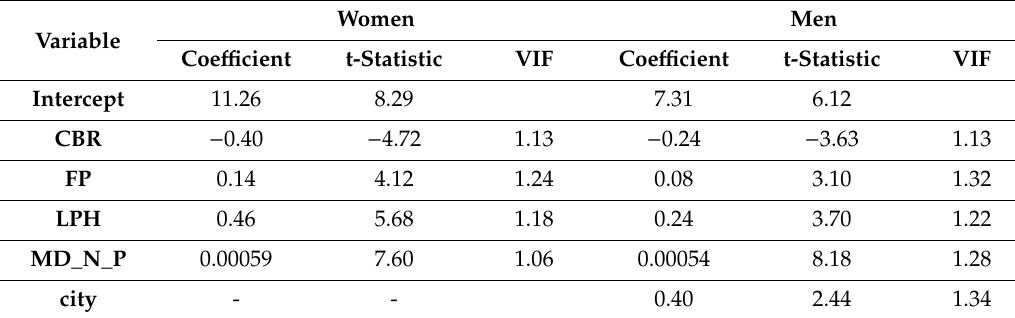
Table 4. Summary of OLS